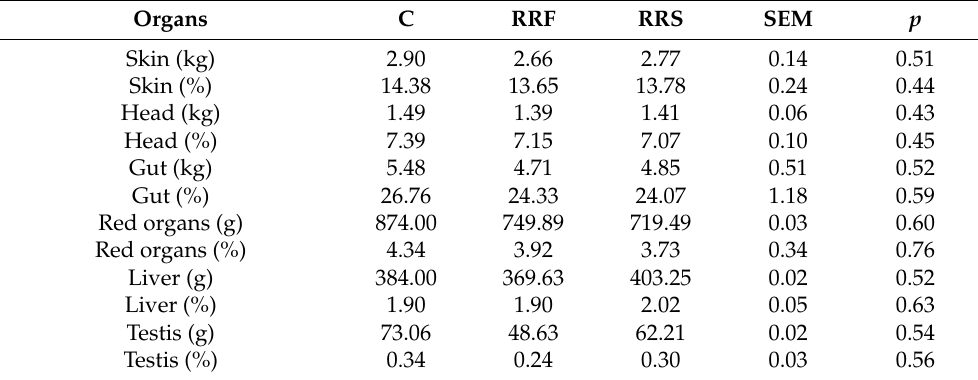
Table 3. Fresh organ weights and proportion (%) in EBW of Barbarine lambs fed RR-based concentrate.